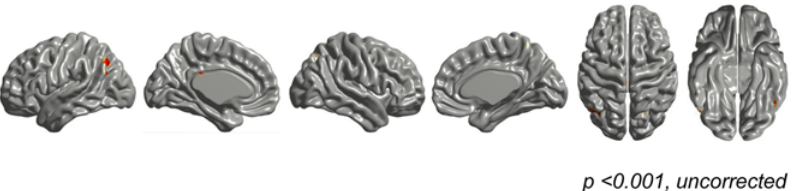
Fig 4. Correlation of changes in cognitive functions and changes in cortical thickness. (A) In the traditional group, changes in the raw scores of visual memory are positively correlated with those of cortical thickness in the right inferior temporalgyrus and right subgenual cingulate region (uncorrected P < 0.001). (B) For the robot group, changes in the raw scores of executive function are positively correlated with those of left temoporo-parietal junction as well as left inferior temporal gyrus (uncorrected P < 0.001).